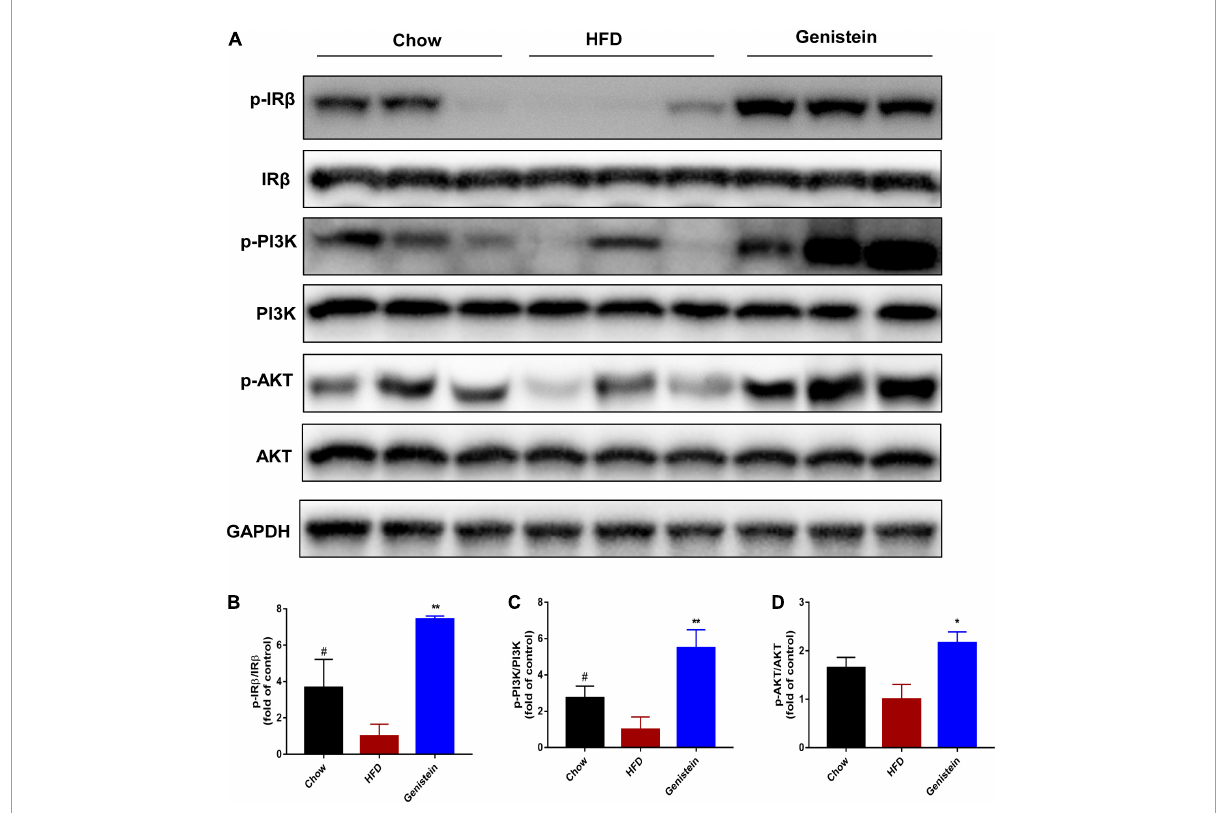
FIGURE2 Genistein improves insulin sensitivity through activating hepatic IR β /PI3K/AKT pathway. (A) Western blot for p-IR β , IR β , p-PI3K, PI3K, p-AKT and AKT in mice liver. (B) Quantification for the phosphorylation of IR β . (C) Quantification for the phosphorylation of PI3K. (D) Quantification for